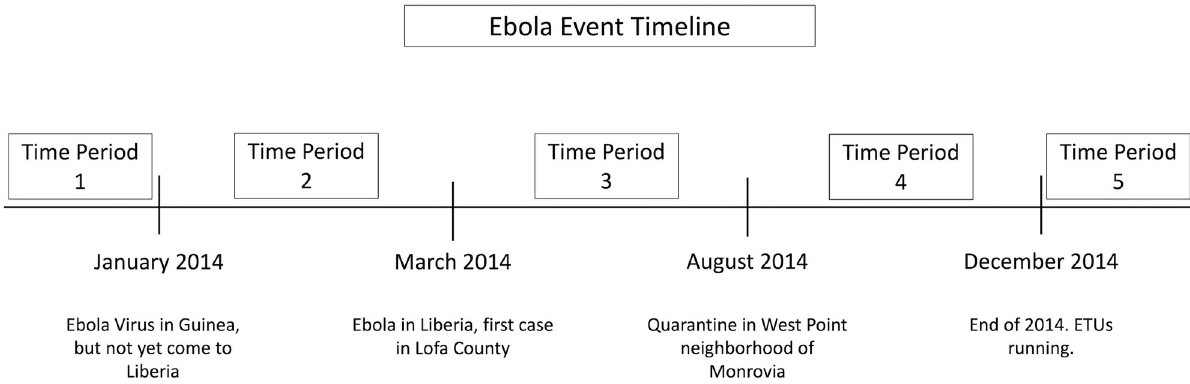
Fig 1. Ebola event timeline defining time periods in relation to recognized